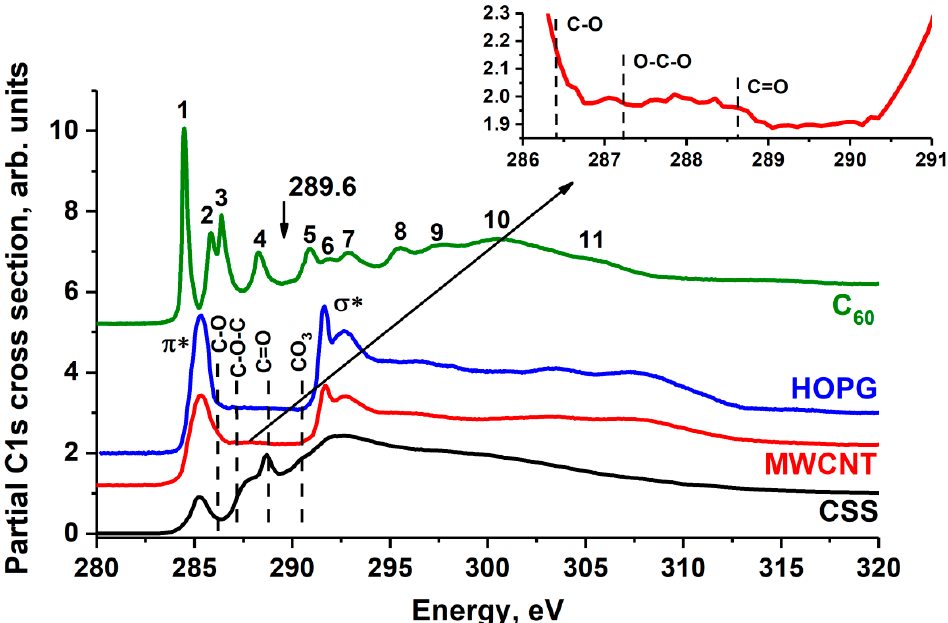
Figure 3. C 1s NEXAFS spectrum of HOPG, MWCNT, CSS and fullerite C 60 . The HOPG spectrum was measured at 45° incidence angle to the sample surface. The spectra are normalized to the same level of the C 1s continuous absorption at the 320 eV photon energy. The arrow indicates the position of the fullerite C 60 C 1s absorption edge (289.60 eV) [40]. In the insert, the C 1s NEXAFS spectra of MWCNT in energy region 286–291 eV is shown.